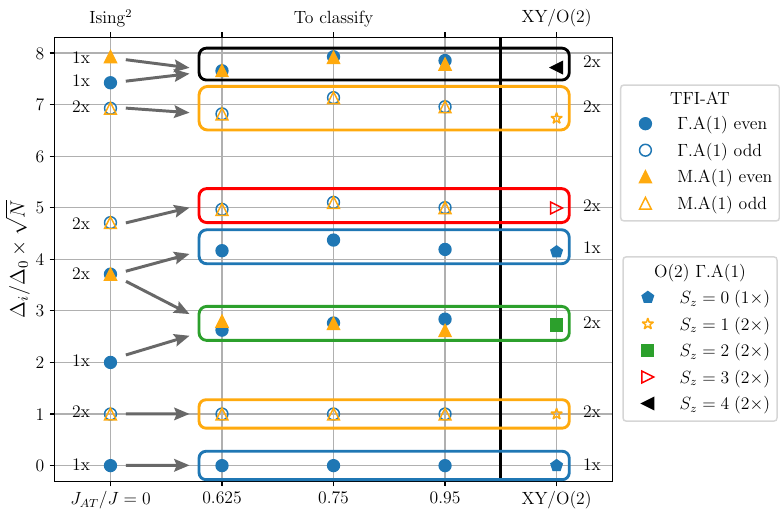
= 0) to emergent XY / O(2) Figure 5: Evolution of the CTES from the Ising 2 ( J AT / J > 0). As a comparison, we show the CTES for the standard XY / O(2) criticality ( J AT theory at κ = 0 [ see Ref. [ 19 ]] . The levels of the Ising 2 transition recombine to emergently match the energies and degeneracies of the standard XY / O(2) critical spectrum as indicated by the arrows and boxes, while becoming strongly different = 1 ( − 1 ) levels under global from the Ising 2 critical spectrum. Even (odd) denote s i spin-inversion symmetry and are shown with full (empty) symbols for the AT-TFI S model. The numbers on the left (right) denote the quasi-multiplicities of the CTES levels in the Ising 2 (XY) CTES,